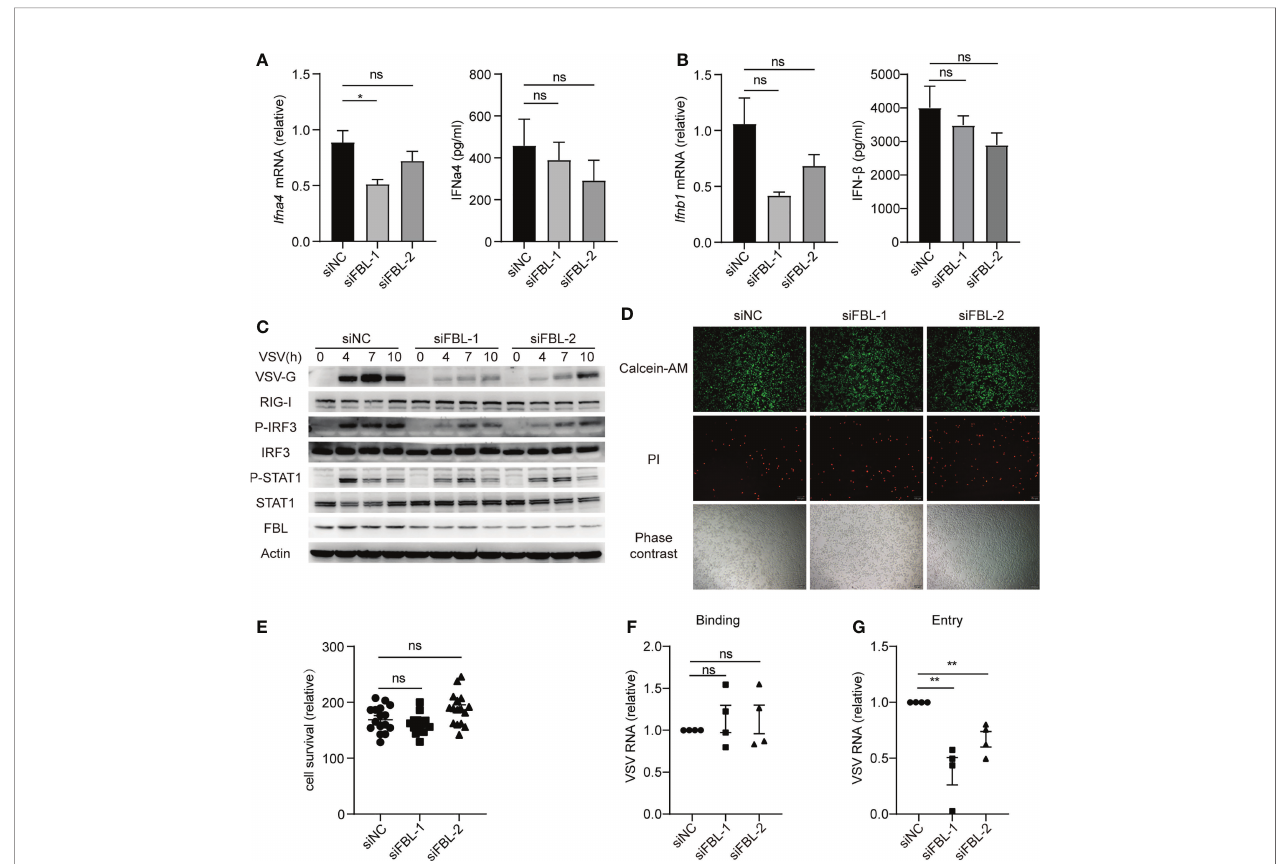
FIGURE 3 | FBL facilitates VSV entry into macrophages at the early stage of infection. (A) qRT-PCR of Ifn a 4 mRNA and ELISA of IFN a 4 protein level in mouse peritoneal macrophages transfected with the indicated siRNAs for 48 h and then infected with VSV for 10 h (n=3); (B) qRT-PCR of Ifnb1 mRNA and ELISA of IFN b protein level in mouse peritoneal macrophages transfected with the indicated siRNAs for 48 h and then infected with VSV for 10 h (n=3); (C) Western blot of innate signaling activation in mouse peritoneal macrophages transfected with the indicated siRNAs for 48 h and then infected with VSV for 0, 4, 7, 10 h; (D) Mouse peritoneal macrophages were transfected with the indicated siRNAs for 48 h then to test cell activity and cytotoxicity by fl uorescence microscopy images. Scale bar, 100 m m (n=4); (E) Calcein/PI cell activity and cytotoxicity assay kit to test cell survival (n=4, repeated four times); (F) Mouse peritoneal macrophages transfected with the indicated siRNAs for 48 h and then infected with VSV for 30 min on the ice, then bound virions were quanti fi ed as viral RNA (vRNA) levels via qRT-PCR (n=4); (G) Mouse peritoneal macrophages transfected with the indicated siRNAs for 48 h and then infected with VSV for 30min in 4°C (n=4). After removal of unbound virus, the temperature was increased to 37°C for 1 h to allow internalization. Then quantify vRNA levels via qRT – PCR. Data are mean ± SEM of biologically independent samples. ns, not signi fi cant, * P < 0.05, ** P < 0.01, two-tailed unpaired Student ’ s t